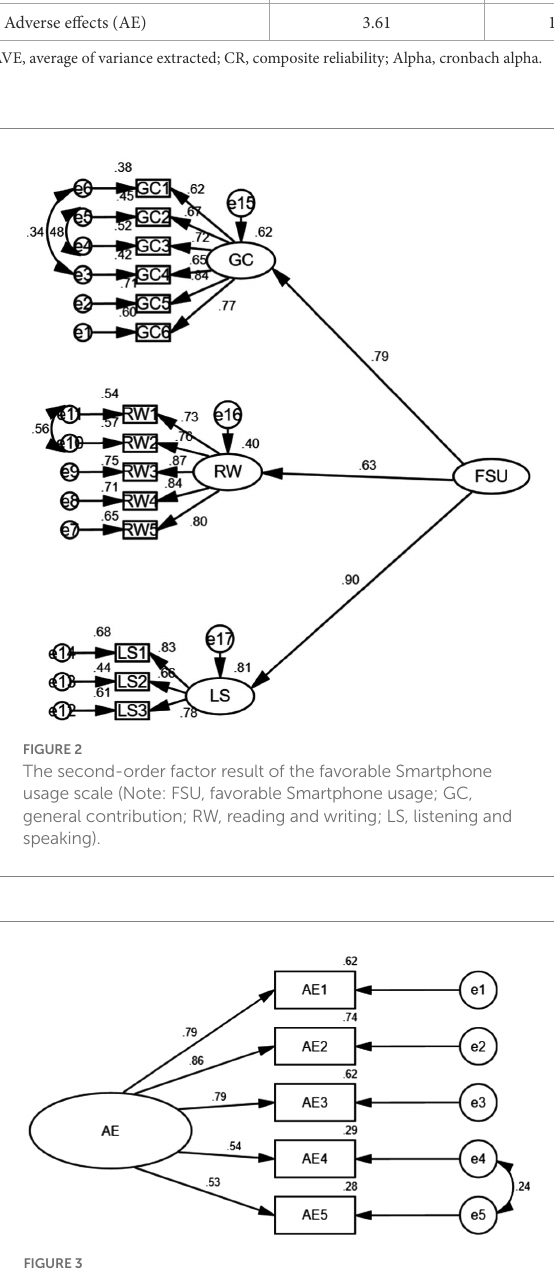
FIGURE 3 Confirmatory factor analysis of adverse effects. (AE, adverse effects).